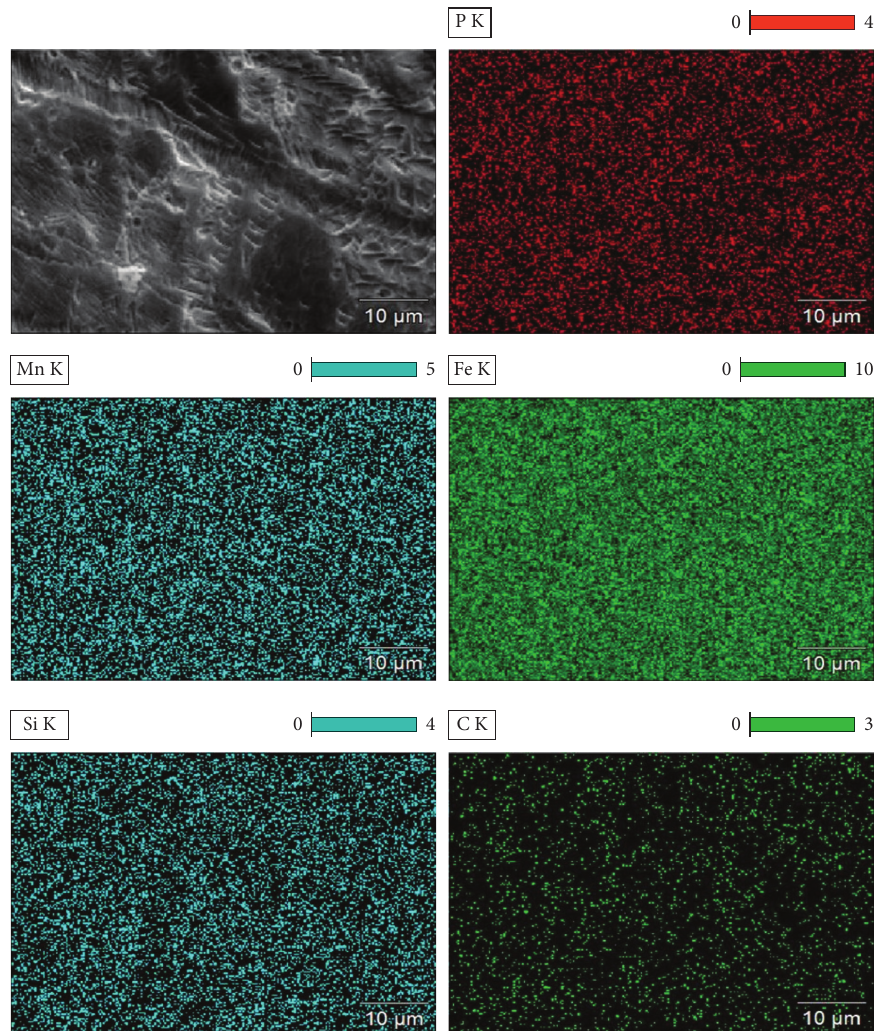
Figure 3: Arrangement picture BSEI and X-ray mapping of the cross segmentation of WC-flyash-covered GrA1 steel exposed to elec- trochemical consumption under 3.5%NaCl